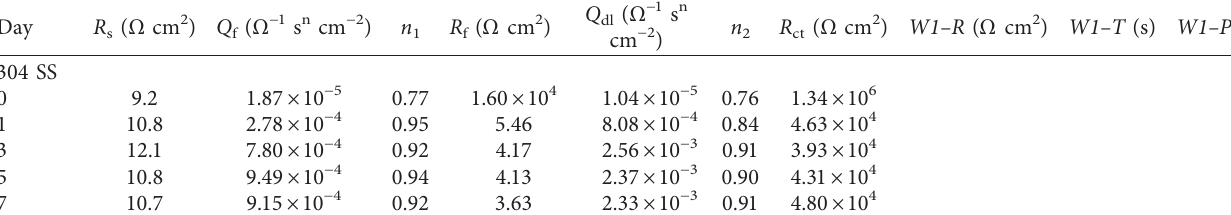
Table 5: Fitted electrochemical parameters from EIS